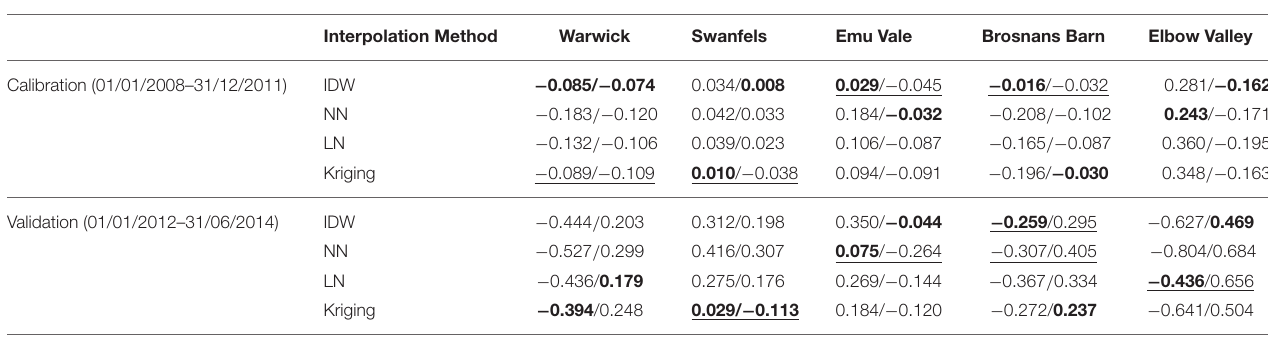
TABLE 5 | As for Table 4 but for bias.